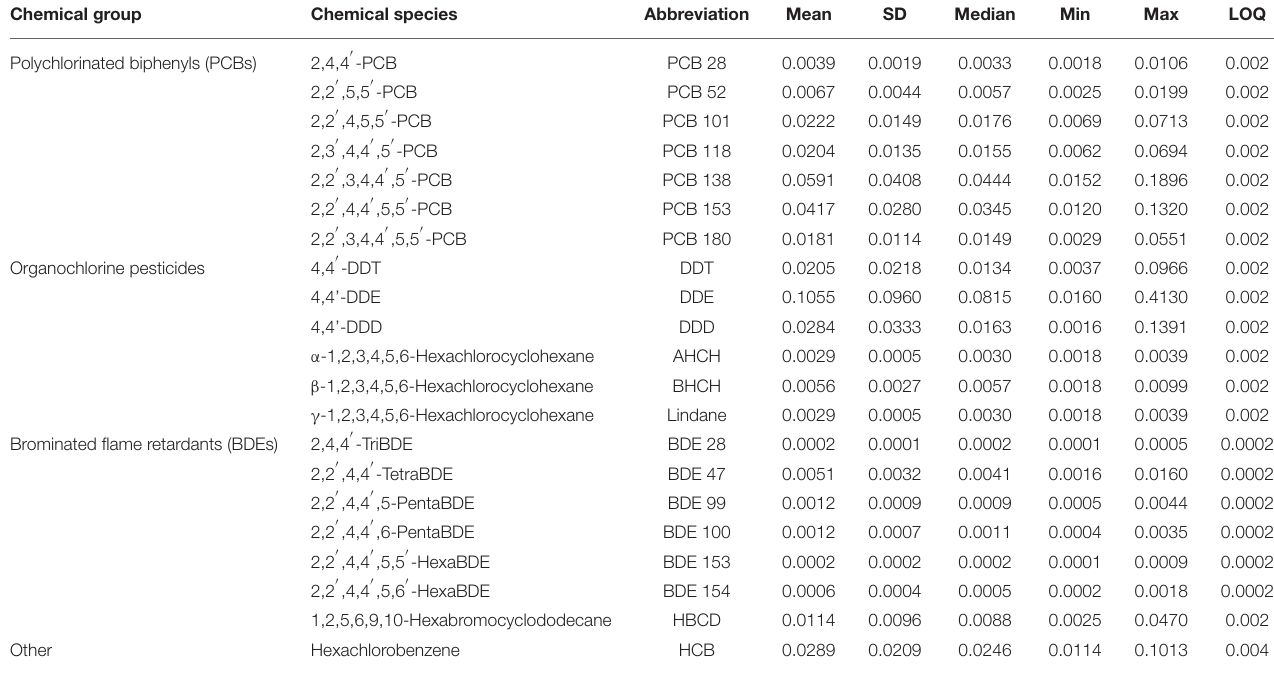
TABLE 1 | Overview of the HOCs in herring muscle tissue and descriptive statistics of their concentrations ( µ g g − 1 lipid weight). Chemical